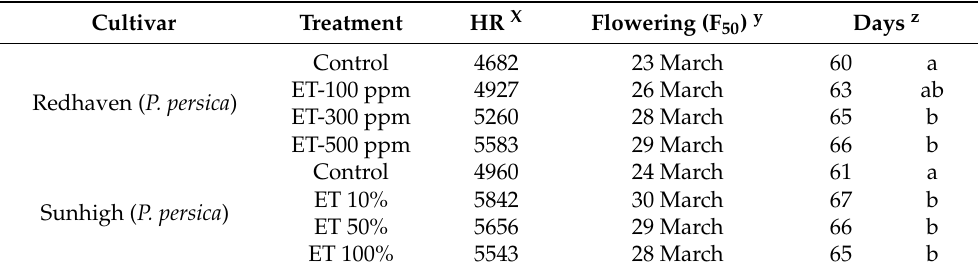
Sunhigh ( P. persica